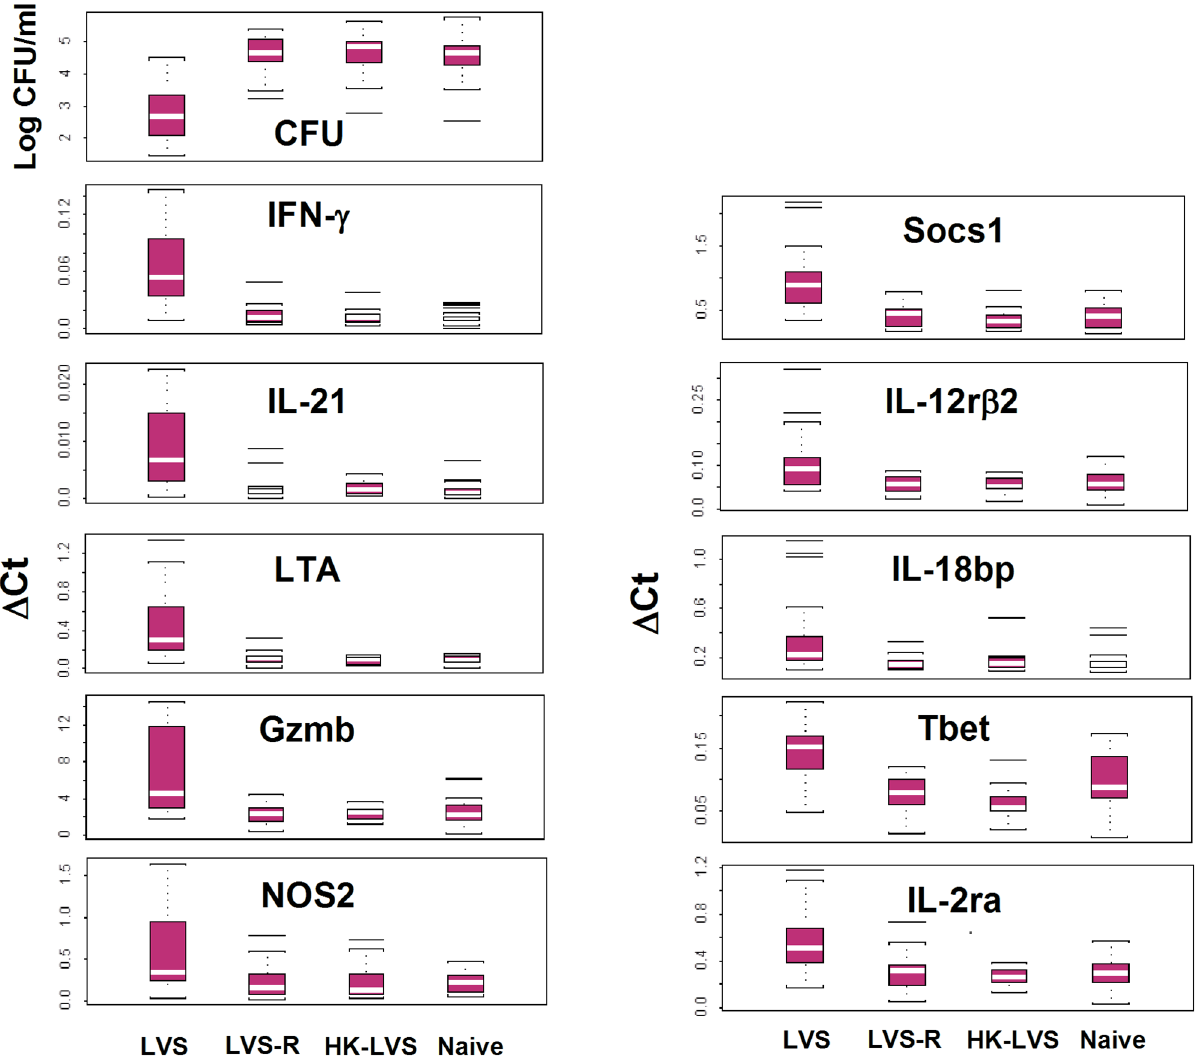
Fig 6. Bacterial replication measurements and relative gene expression measurements discriminate LVS-vaccinated rats from LVS-R-vaccinated, HK-LVS vaccinated, and na ï ve rats. BMM F from Fischer 344 rats were infected with LVS and co-cultured with splenocytes obtained from na ï ve Fischer 344 rats or rats vaccinated with LVS, LVS-R, or HK-LVS. Splenocytes from 22 rats from each group were analyzed individually in studies comprised of 6–8 separate experiments. After two days of co-culture, splenocytes were recovered and used to purify total RNA, then BMM F were lysed to evaluate the recovery of intracellular bacteria. Semi-quantitative gene expression analyses of total RNA from recovered splenocytes were performed using the indicated sets of primers/probes, chosen among those that best reflected the hierarchy of in vivo efficacy. Values shown indicate median (white line), 1 st and 3 rd quartiles (lower and upper box), and maximum and minimum values (upper and lower line). Bacterial growth and gene expression were significantly different for each variable in splenocytes after vaccination with LVS compared to that of naïve, LVS-R, and HK-LVS groups (p <